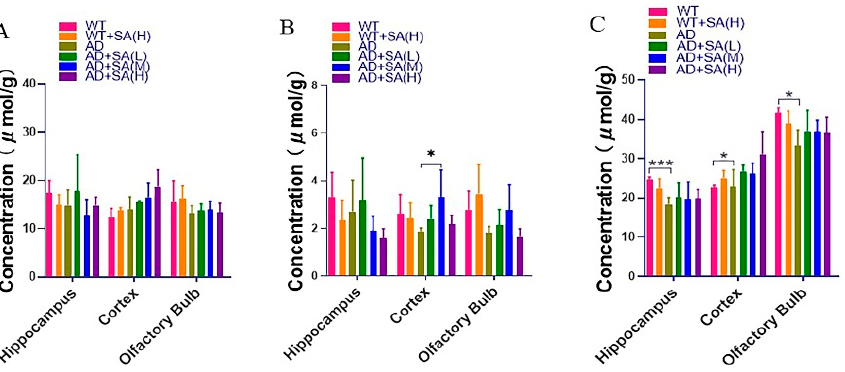
Figure 8. Effect of SA treatment on common small molecules in the brain in 2 × Tg AD mice. ( A ) Myo-Inositol. ( B ) Glycine. ( C ) Taurine. Student’s t test was used for statistical analysis. Error bars represent the mean ± SEM ( n = 4; * p < 0.05; *** p < 0.001).